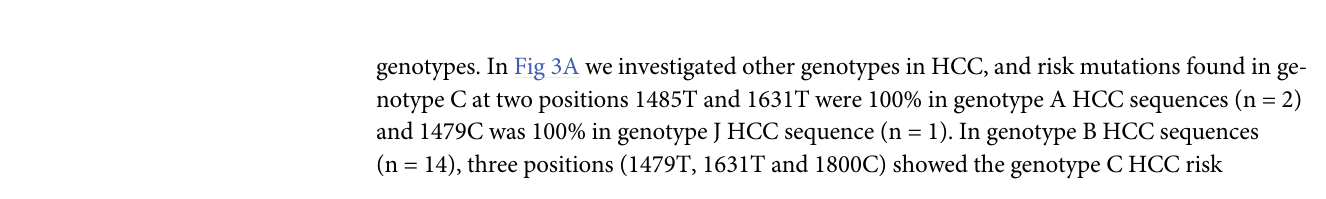
genotypes. In Fig 3A we investigated other genotypes in HCC, and risk mutations found in ge- notype C at two positions 1485T and 1631T were 100% in genotype A HCC sequences (n = 2) and 1479C was 100% in genotype J HCC sequence (n = 1). In genotype B HCC sequences (n = 14), three positions (1479T, 1631T and 1800C) showed the genotype C HCC risk